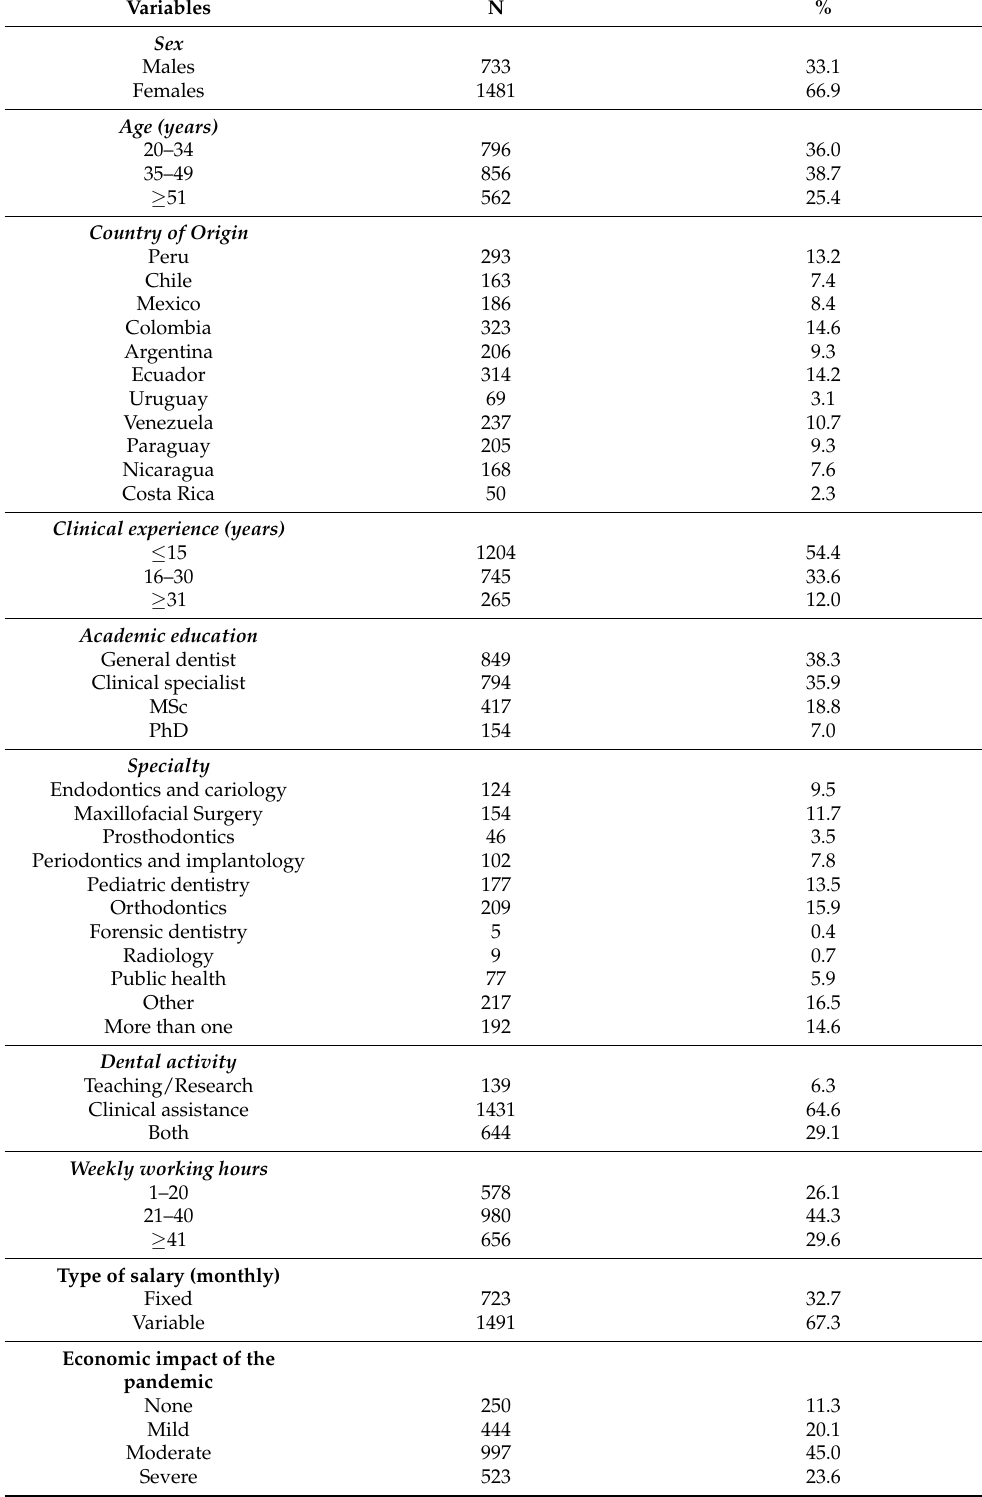
Table 1. Characteristics of the participating dentists (n =